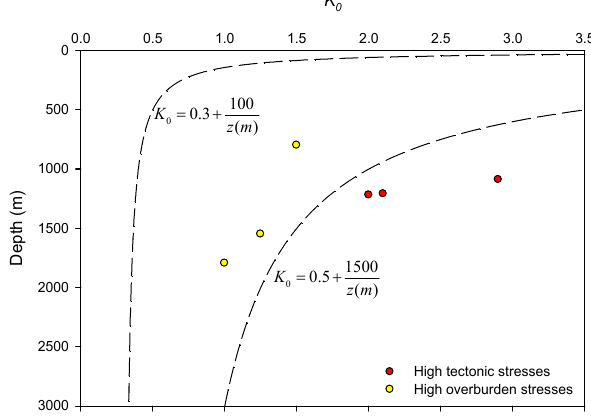
Figure 2. Measured horizontal to vertical stress ratio ( K 0 ) at various depths, z (m).